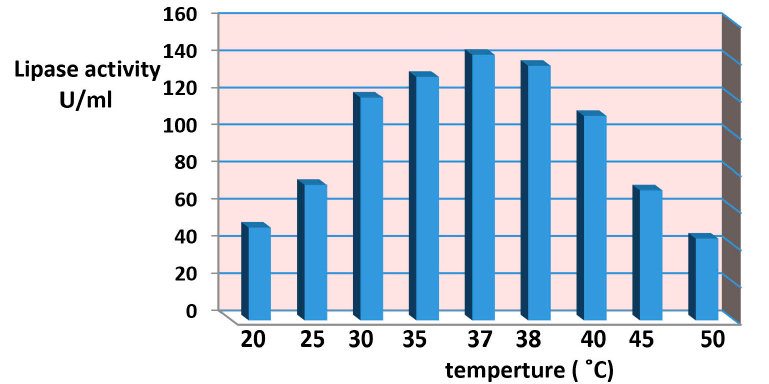
Fig. 6. Effect of temperature ranges in lipase